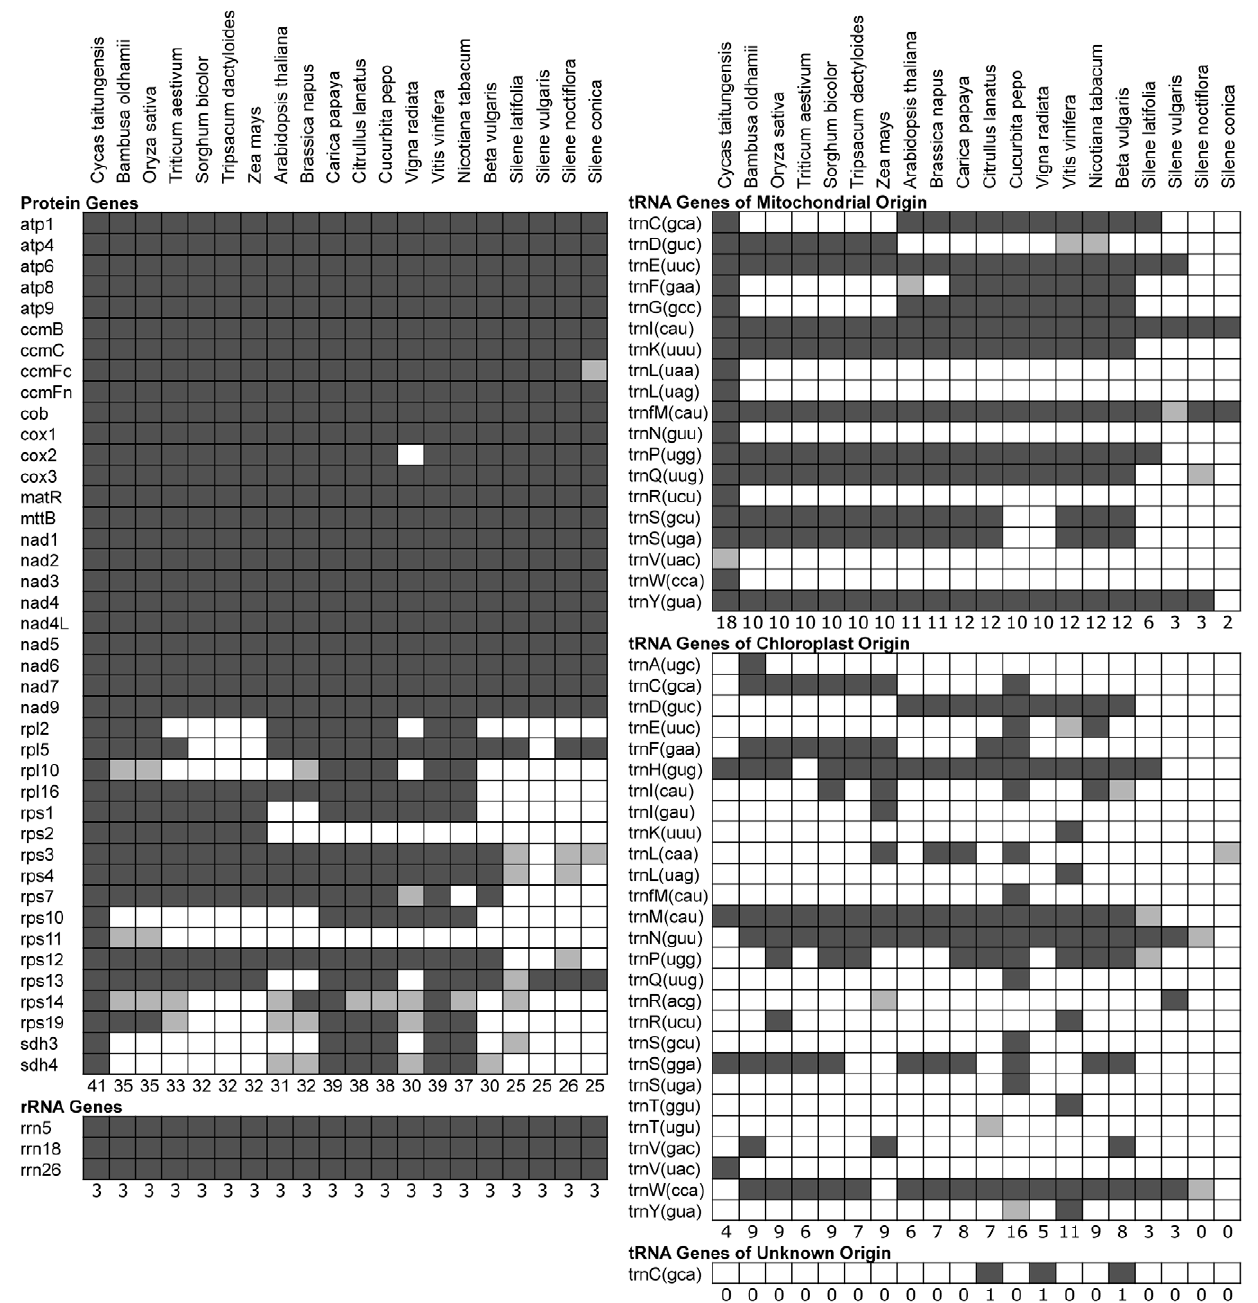
Figure 4. Protein and RNA gene content in sequenced seed plant mitochondrial genomes. Dark shading indicates the presence of an intact reading frame or folding structure, whereas light shading indicates the presence of only a putative pseudogene. The numbers at the bottom of each group indicate the total number of intact genes for that species. Note that the ccmFc gene, which is universally present in all other seed plants surveyed to date [104], is classified as a pseudogene in S. conica . It has experienced numerous structural mutations in this lineage, including multiple frame shifts in the second exon that introduce premature stop codons. However, cDNA sequencing confirmed that this gene is transcribed, spliced, and RNA edited in S. conica (unpublished data), so it is possible that the gene is still functional in its truncated form. In some cases, the presence of an intact gene may not indicate functionality. This is particularly true for tRNA genes embedded within recently transferred regions of plastid DNA [20,105]. For example, the trnN(guu) and trnR(acg) genes in S. vulgaris may not be functional, as they are within a 2.6-kb region that appears to have been recently transferred from the plastid genome (on the basis of its perfect sequence identity with the exception of a single 18-bp deletion). These two tRNA genes are not orthologous to the plastid-derived copies of trnN(guu) and trnR(acg) in other seed plant mitochondria. Intron-containing plastid-derived tRNA genes such as trnA(ugc) in Bambusa , trnV(uac) in Cycas , trnK(uuu) in Vitis , and trnI(gau) in Zea are also unlikely to be functional. In Cycas , the trnL(uaa) , trnP(ugg) , trnQ(uug) , trnR(ucu) , and trnV(uac)- Y genes are classified on the basis of sequence homology to other land plant tRNAs even though their genomically encoded anticodons differ (CAA, CGG, CUG, CCU, and CAC, respectively). It is possible that these anticodons undergo C-to-U RNA editing to restore the ancestral codon as has been observed in other vascular plants [106,107]. Plastid-derived tRNAs with substitutions in their anticodons, such as Citrullus trnT(ugu) and Silene latifolia trnP(ugg) , are also classified (as pseudogenes) on the basis of homology.